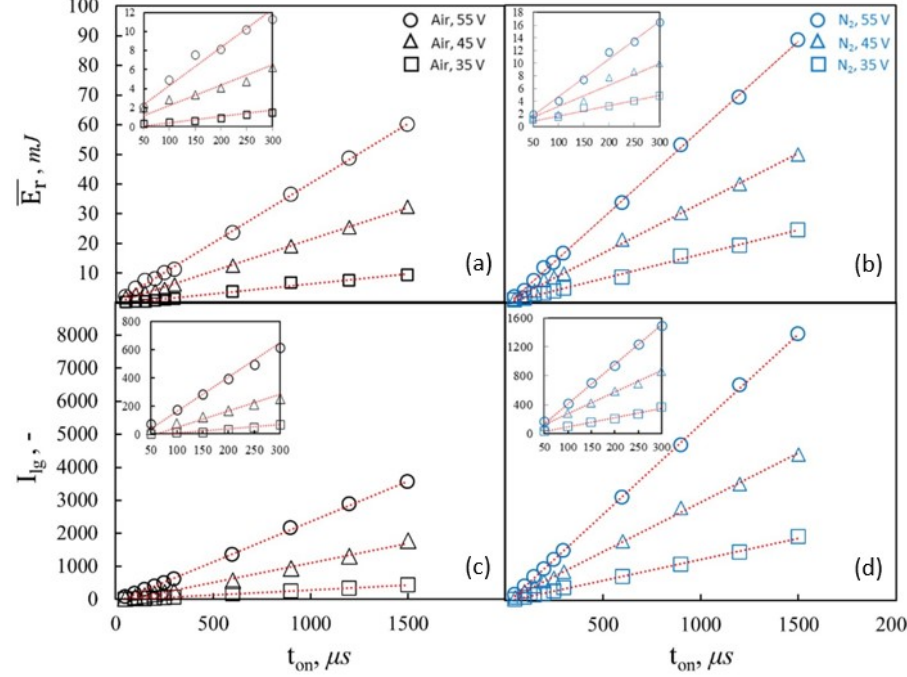
Figure 14. Thermal energy released ( a , b ) and luminous emission ( c , d ) plotted against the ton at three V d level in air (black markers) and nitrogen (blue markers). Each graph contains a boxplot focused on the interval from 50 μ s to 300 μ s.